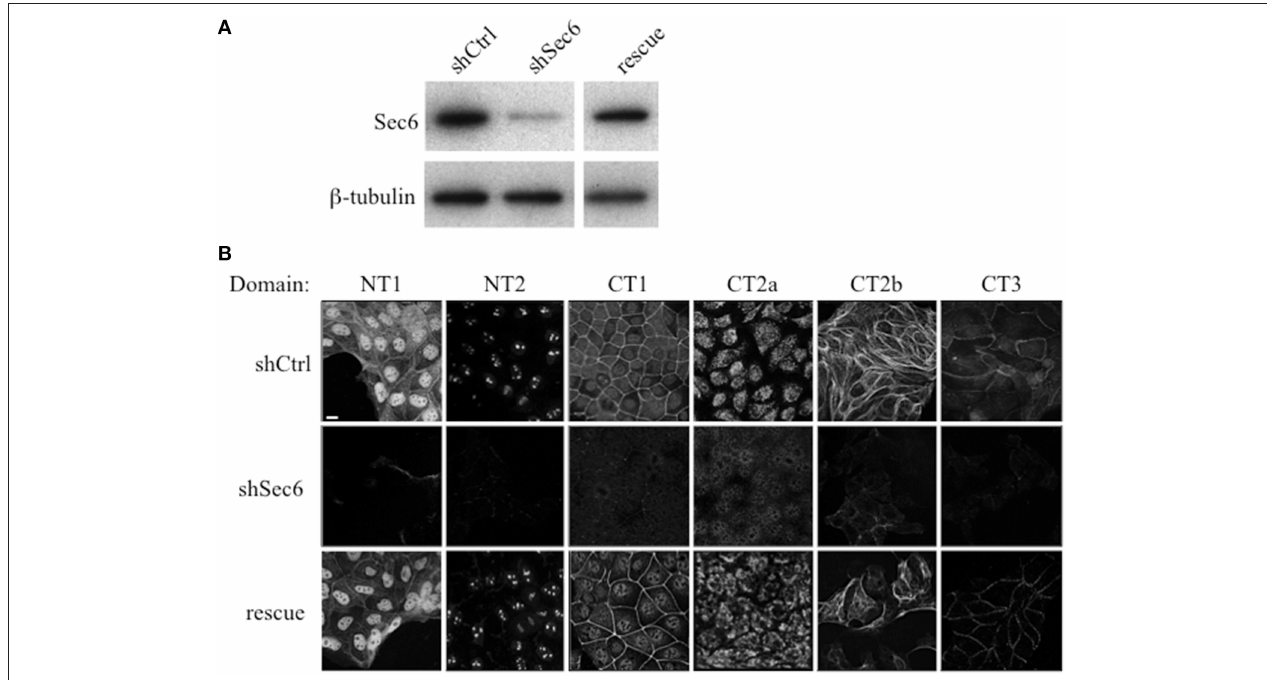
FIGURE 7 | Sec6 knockdown eliminates, and re-expression restores labeling with all Sec6 mAbs in MDCK cells. (A) Sec6 knockdown and rescue. MDCK cells were transduced with recombinant lentiviral vectors carrying either non-targeting shRNA (shCtrl) or shRNA targeting Sec6 (shSec6). Immunoblot analysis confirmed that Sec6 protein expression was reduced in shSec6 cells by > 90% when normalized to loading control ( β -tubulin). Rescue cell lines were established by transduction of shSec6 cells with recombinant retroviral vectors carrying hairpin-resistant Sec6 cDNA. Immunoblot analysis confirmed that Sec6 protein expression was restored to nearly identical levels as those in shCtrl cells. (B) Control (shCtrl), Sec6 knockdown (shSec6), and Sec6 rescue MDCK cells were processed for immunofluorescent labeling with antibodies to indicated Sec6 subdomains, as described in Figure 2 . Bar = 10 µ m.